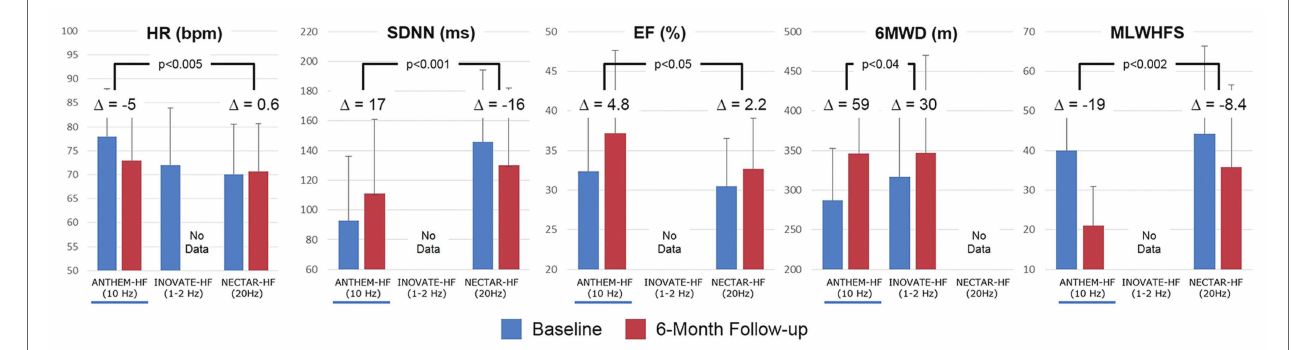
FIGURE 10 | Clinical responses for the three major vagus nerve stimulation trials for HFrEF at baseline (blue) and 6-month follow up (red). Improvement for most parameters were noted for ANTHEM-HF, but unstudied or not met for INOVATE-HF or NECTAR-HF. Outcomes included heart rate (HR), standard deviation of NN intervals (SDNN, a heart rate variability time domain measure), ejection fraction, 6 minute walking distance test, and minnesota living with heart failure score. Adapted from Anand et al. (2020) with